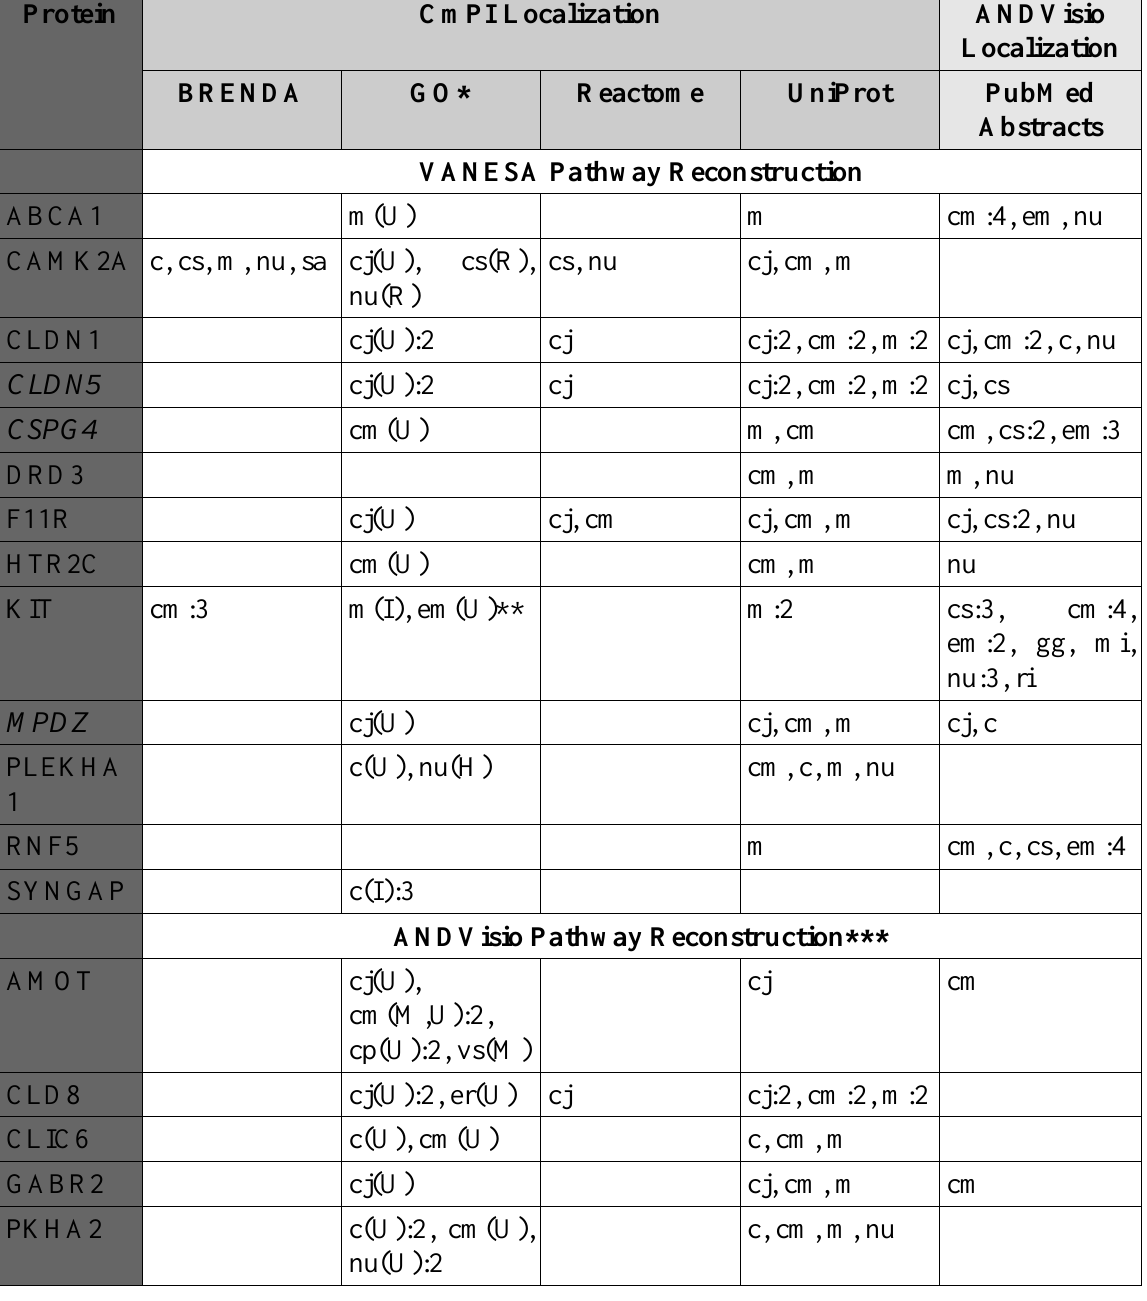
Table 3: Localization Results in CmPI and